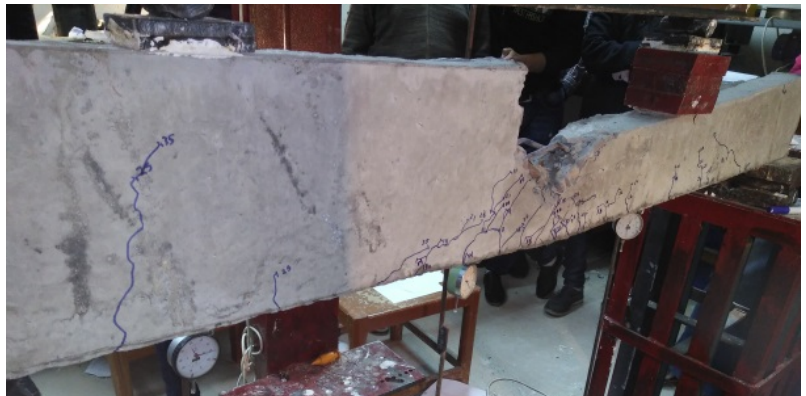
Figure 14. Crack pattern of beam B3 *. Failure occurred at the depth change for both beams B1 (without stirrups) and B3 (with 8 mm@200 mm) as a result of the lack of stirrups or insufficient stirrups in the area of the depth change. In contrast, as shown in Figure 15, the usage of 8 mm spaced at 100 mm in B4 was successful in moving the failure from the place of the depth change to the smaller depth area. With more stirrups, the collapse occurred later and the total load was higher. There were 14 cracks in total, 8 of which had a little depth of 150 mm and 6 of which had a depth of 250 mm. As depicted in Figure 15, the cracks in this beam were concentrated close to the loading point. In comparison to the other beams on which the test was conducted, the results showed that beam B4’s collapse needed the largest loads. The higher steel bars buckled, and tension cracks at the right half span with a smaller depth contributed to the failure of this beam.